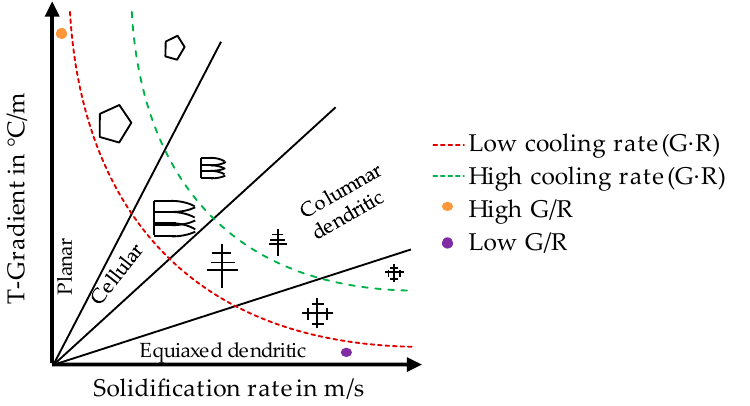
Figure 4. Effect of temperature gradient 𝐺 and solidification rate 𝑅 on the morphology and size of the solidification microstructure [30].